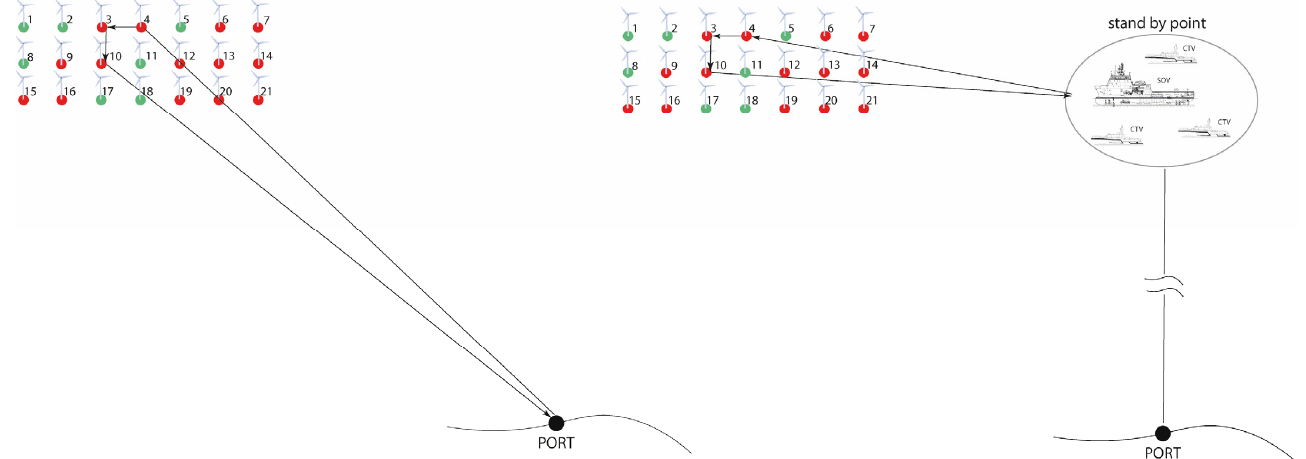
Figure 1. Onshore or offshore supply base location and the routing illustration. The red dots represent the turbines that are stopped waiting for maintenance.